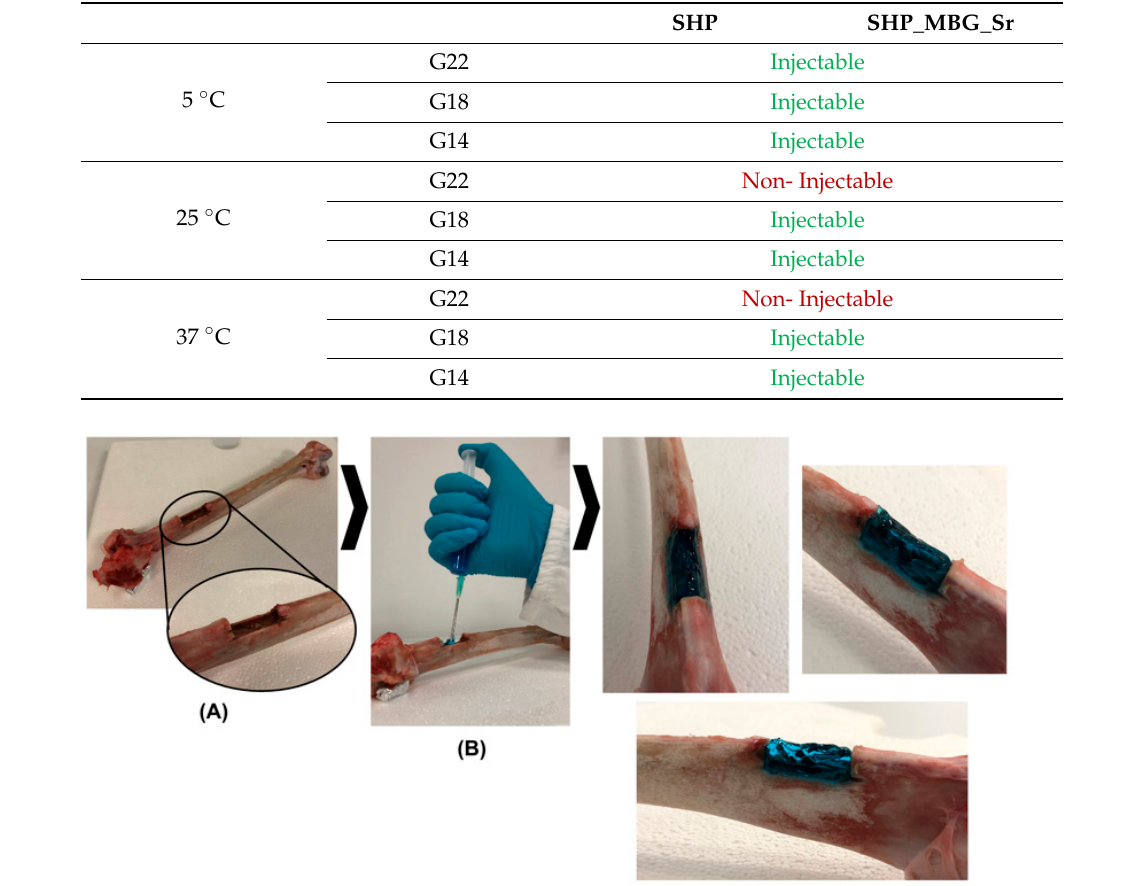
Table 1. Qualitative evaluation of injectability for SHP and SHP_MBG_Sr sol-gel systems. Tests were conducted by different users at three temperatures (i.e., 5, 25 and 37 ◦ C) through three different